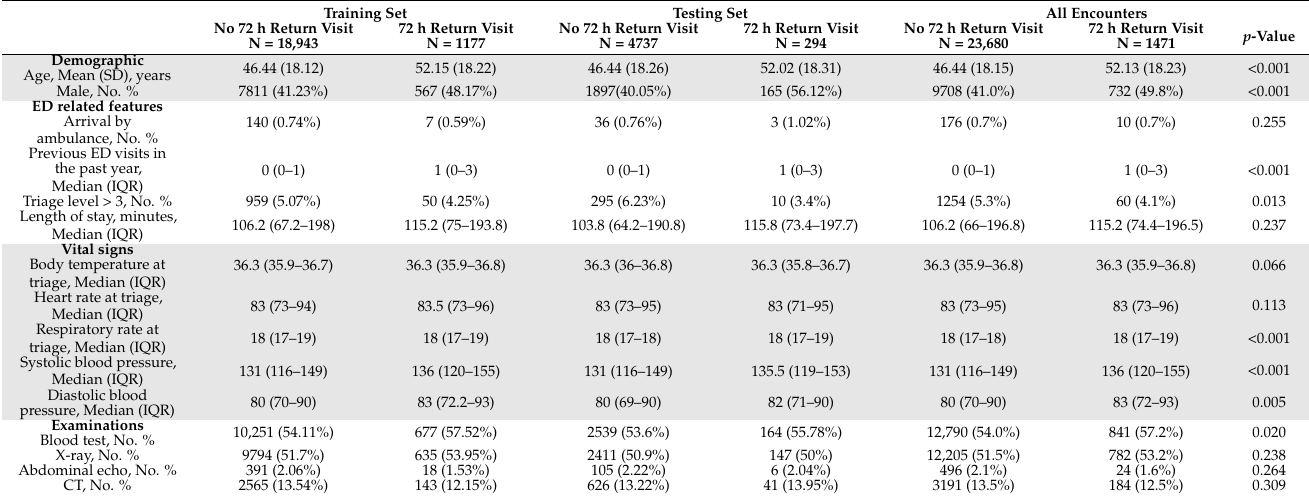
Table 1. Summary statistics for demographic and clinical features of the data.